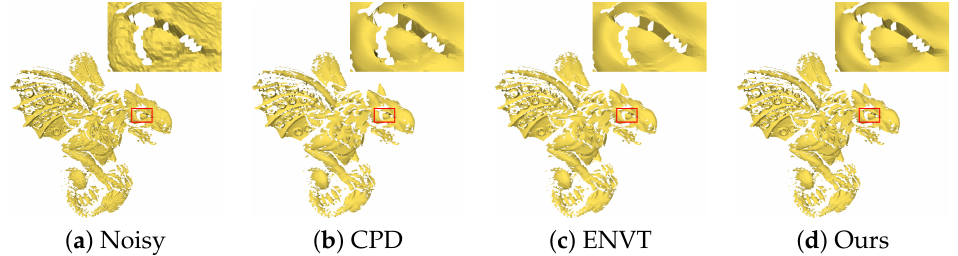
Figure 16. Comparison of the denoising results for the scan model. The results From left to right: [9,45] and ours. The gargoyle model is corrupted by 3D scanner